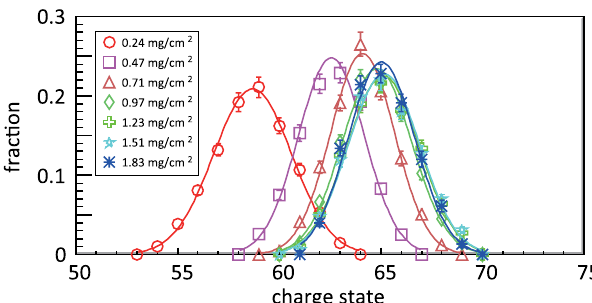
6. Results of Gaussian fitting to the charge-state distribu- tion for